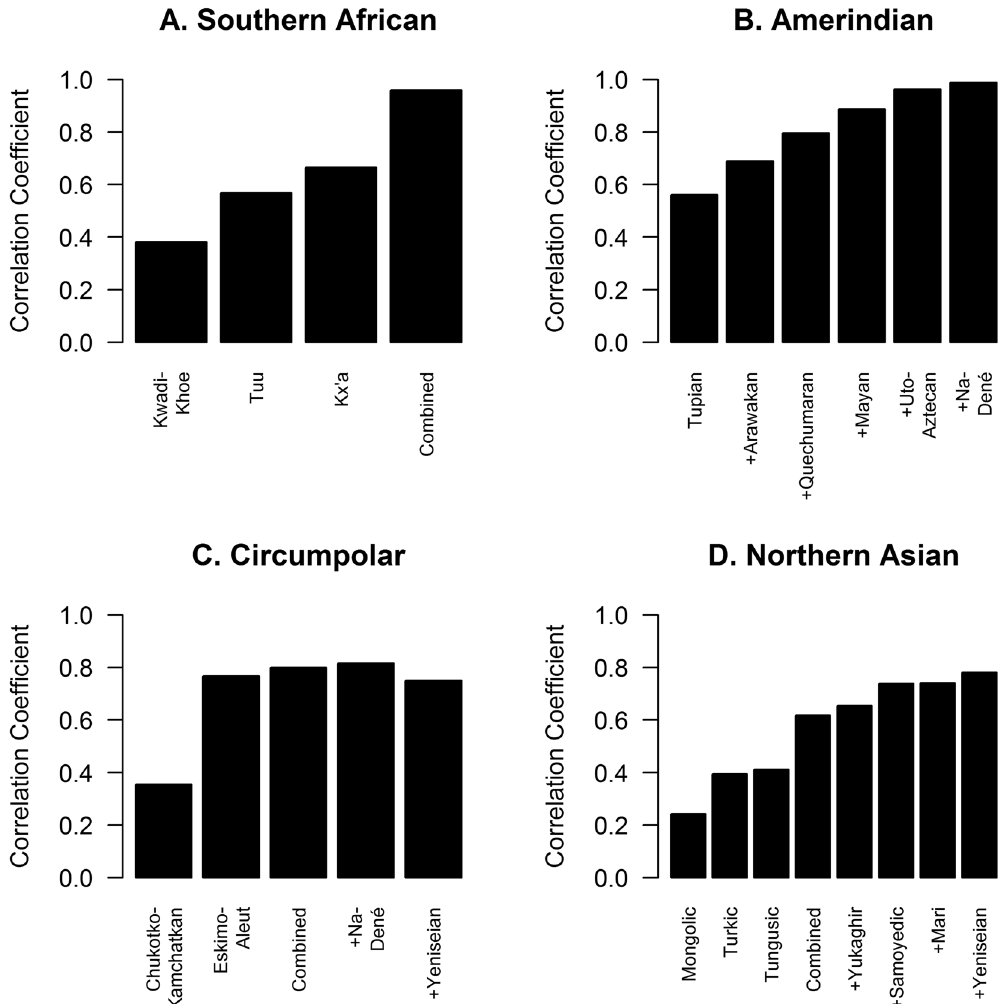
Figure 3. Correlation of ancestry and language. ( A ) “Combined” refers to Kwadi-Khoe, Tuu, and Kx’a, previously referred to collectively as Khoisan. ( B ) “ + ” indicates the combination of the listed language plus all languages listed to the left. Tupian, Arawakan, Quechumaran, Mayan, and Uto-Aztecan are referred to collectively as Amerind. ( C ) “Combined” refers to Chukotko-Kamchatkan and Eskimo-Aleut, referred to collectively as Paleo-Siberian. Note that inclusion of Yeniseian worsens the correlation. ( D ) “Combined” refers to Mongolic, Turkic, and Tungusic, referred to collectively as